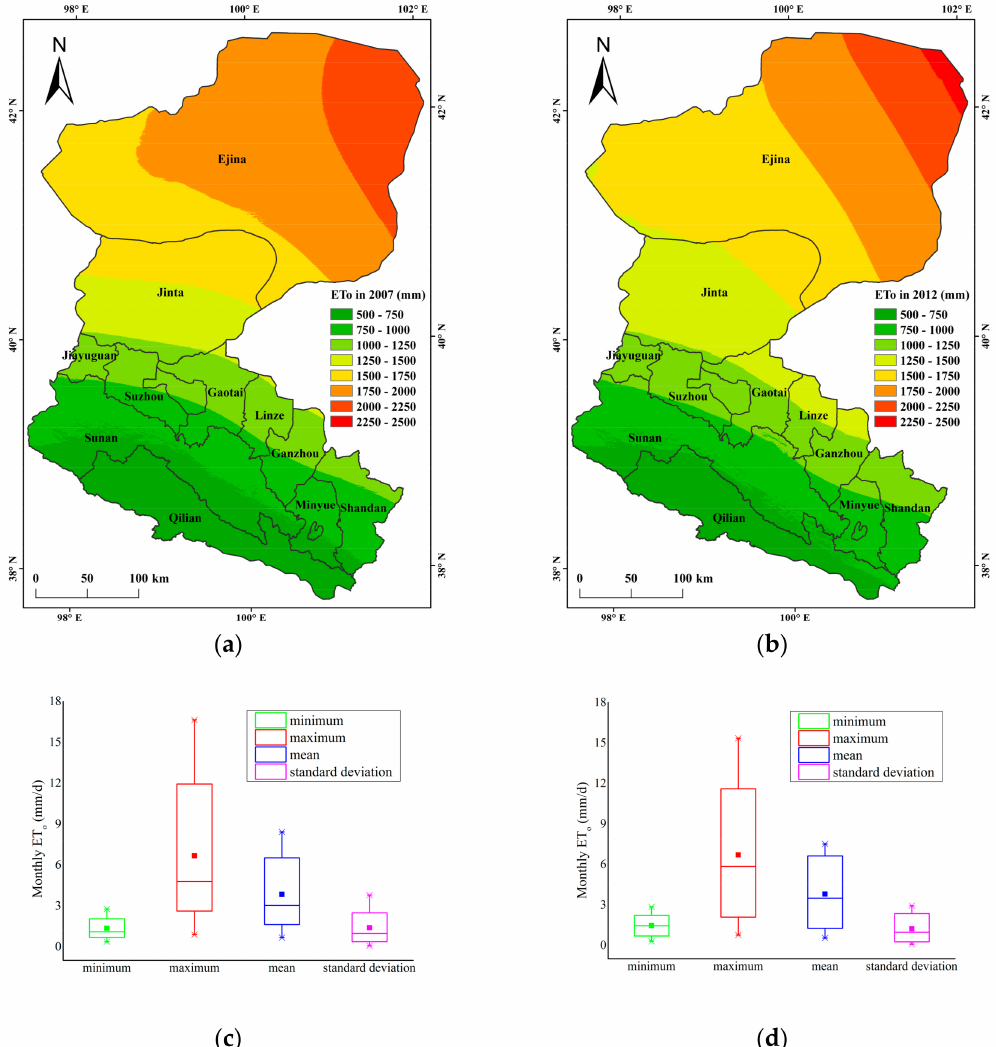
Figure 3. HRB ET o values for 2007 and 2012: ( a ) Spatial distribution of ET o in 2007; ( b ) Spatial distribution of ET o in 2012; ( c ) Monthly mean, maximum, and minimum ET o , as well as monthly standard deviation for 2007; ( d ) Monthly mean, maximum, and minimum ET o , as well as monthly SD for